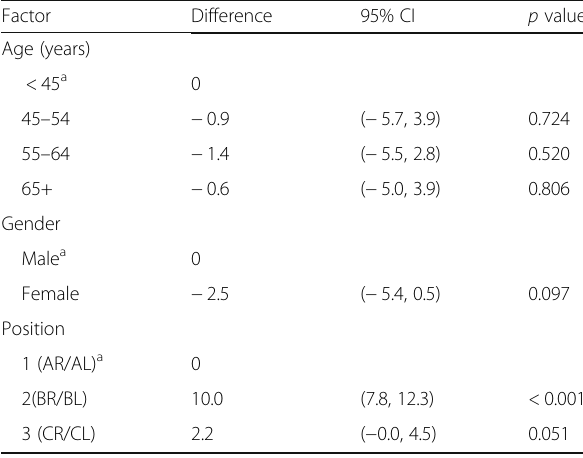
Table 6 Results from a multivariable random effects regression model of all angles on age (in groups) gender and point of measurement